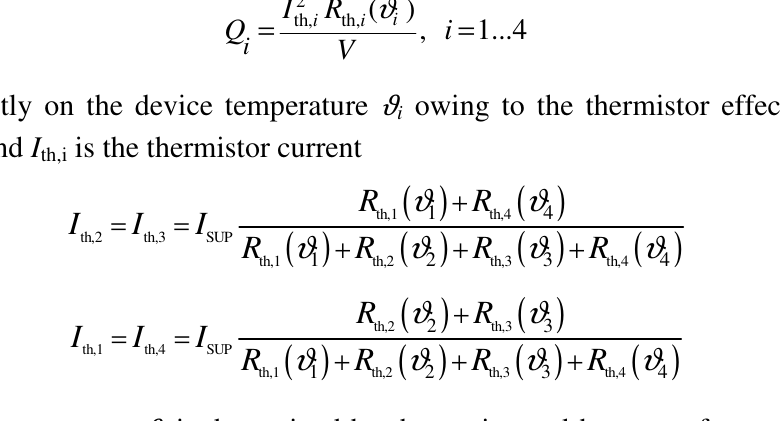
= 70 µA. Both voltages U SUP